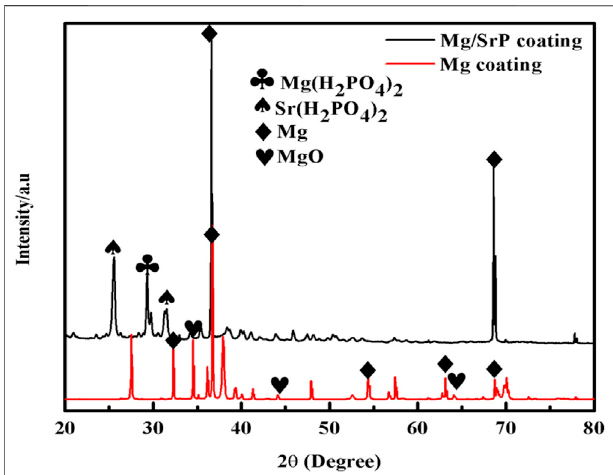
FIGURE 3 | XRD pattern of Mg and Mg/SrP coatings on Ti